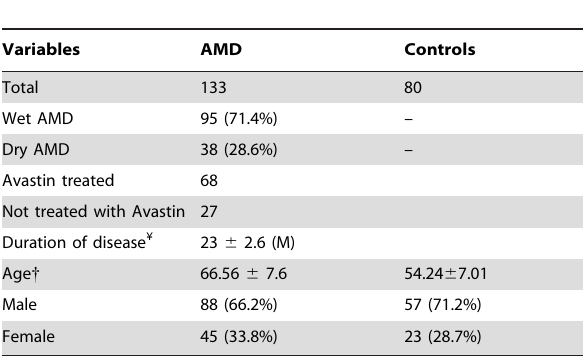
Table 2. Demographic characteristics of Controls and AMD patients.